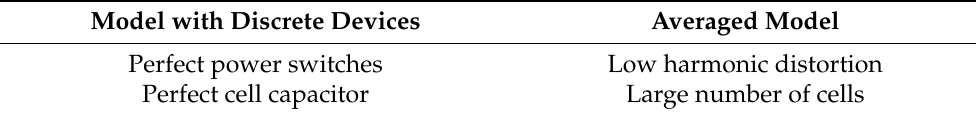
Table 2. Assumptions considered to model a modular multilevel converter (MMC) cluster.